Question: Does the figure show an increasing or a decreasing trend?
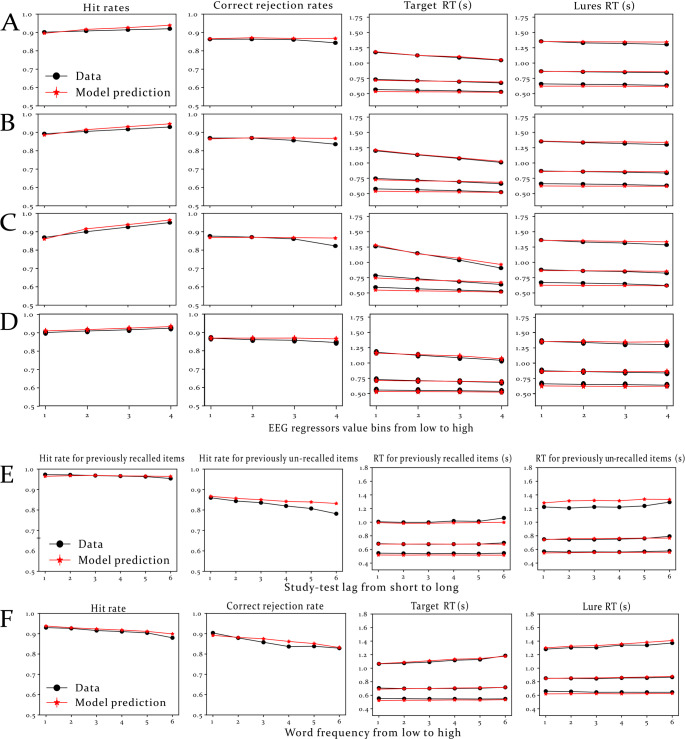
Answer: increasing